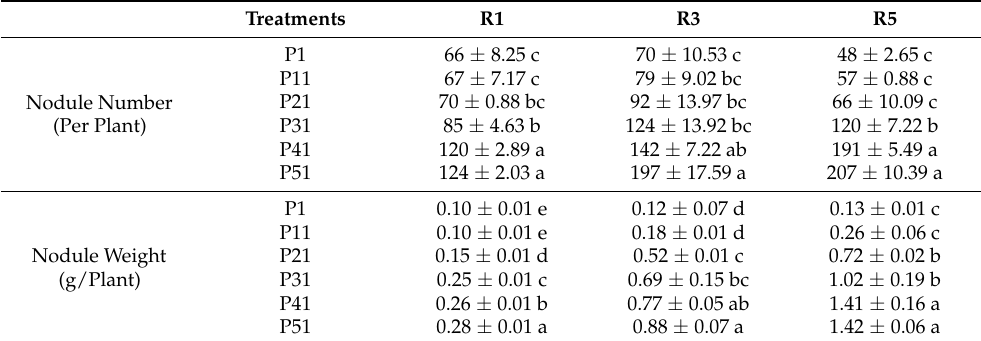
Table 1. Effects of different phosphorus supply levels on soybean nodule number and nodule dry weight.